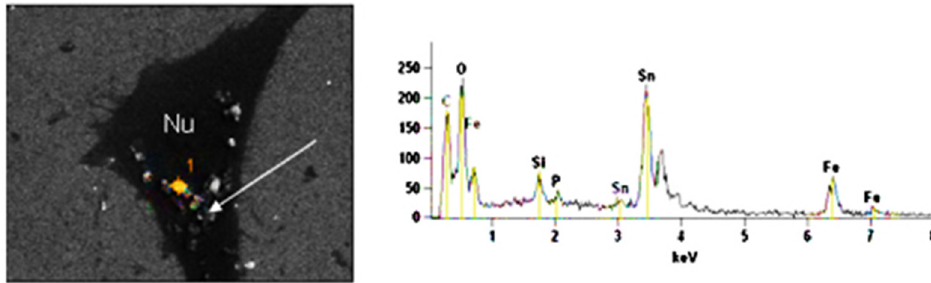
Figure 9. Typical FE-SEM/EDX result. [78] Reproduced with permission from Naji et al., Mar. Pollut. Bull.; published by Elsevier, 2019.